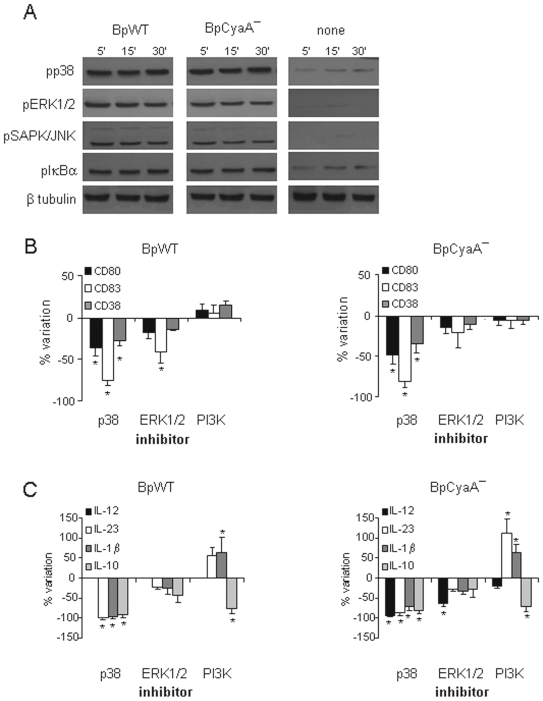
Analysis of MyD88 -dependent pathway induction.
A MDDC were either untreated or treated with BpWT or BpCyaA−. Phosphorylation of p38, ERK1/2, SAP/JNK and IκB-α was determined at the indicated time-points by Western blot. A single gel was run and blotted to detect phosphorylated proteins and β tubulin to normalize the results. Data are from one representative out of four independent experiments performed with MDDC obtained from different donors. B MDDC were treated as in panel A, either in the absence or presence of p38 inhibitor (SB203580), ERK1/2 inhibitor (PD98059) or PI3K inhibitor (LY294002) for 48 h. Results of seven independent experiments performed with MDDC obtained from different donors are expressed as the percent of change of maturation markers (CD80, CD83, CD38) with respect to the corresponding stimulus in the absence of inhibitors. Mean ± SE of marker expression in MDDC not treated with inhibitors was for BpWT: CD80 (MFI) = 48±6; CD83 (%) = 23±6; CD38 (MFI) = 18±4; for BpCyaA−: CD80 (MFI) = 72±11; CD83 (%) = 36±7; CD38 (MFI) = 46±5. * p<0.05 vs control, calculated from the raw data. C MDDC were treated as in panels A and B. Results of ten (IL-12p70), eight (IL-23 and IL-10) and 5 (IL-1β) independent experiments performed with MDDC obtained from different donors, measured by ELISA, are expressed as the percent of change of cytokines with respect to the corresponding stimulus in the absence of inhibitors. Mean ± SE of cytokine production (pg/ml) in MDDC not treated with inhibitors was for BpWT: IL-12p70 = 0±0; IL-23 = 310±70; IL-1β  = 330±85; IL-10 = 2034±605; for BpCyaA−: IL-12p70 = 374±43; IL-23 = 672±140; IL-1β = 600±87; IL-10 = 2477±593. * p<0.05 vs control, calculated from the raw data.